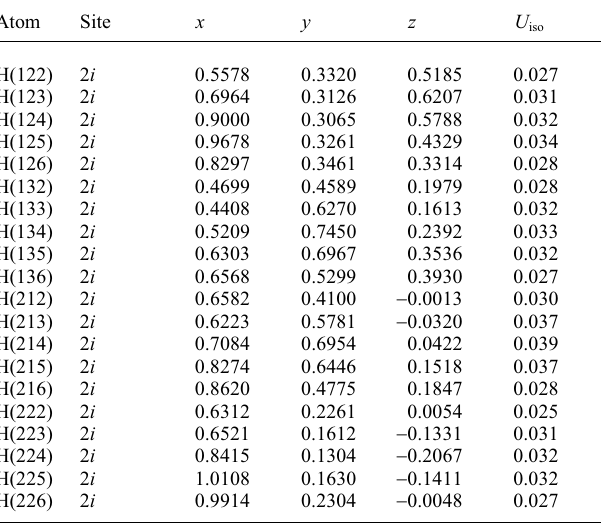
Table 3. Atomic coordinates and displacement parameters (in Å 2 )